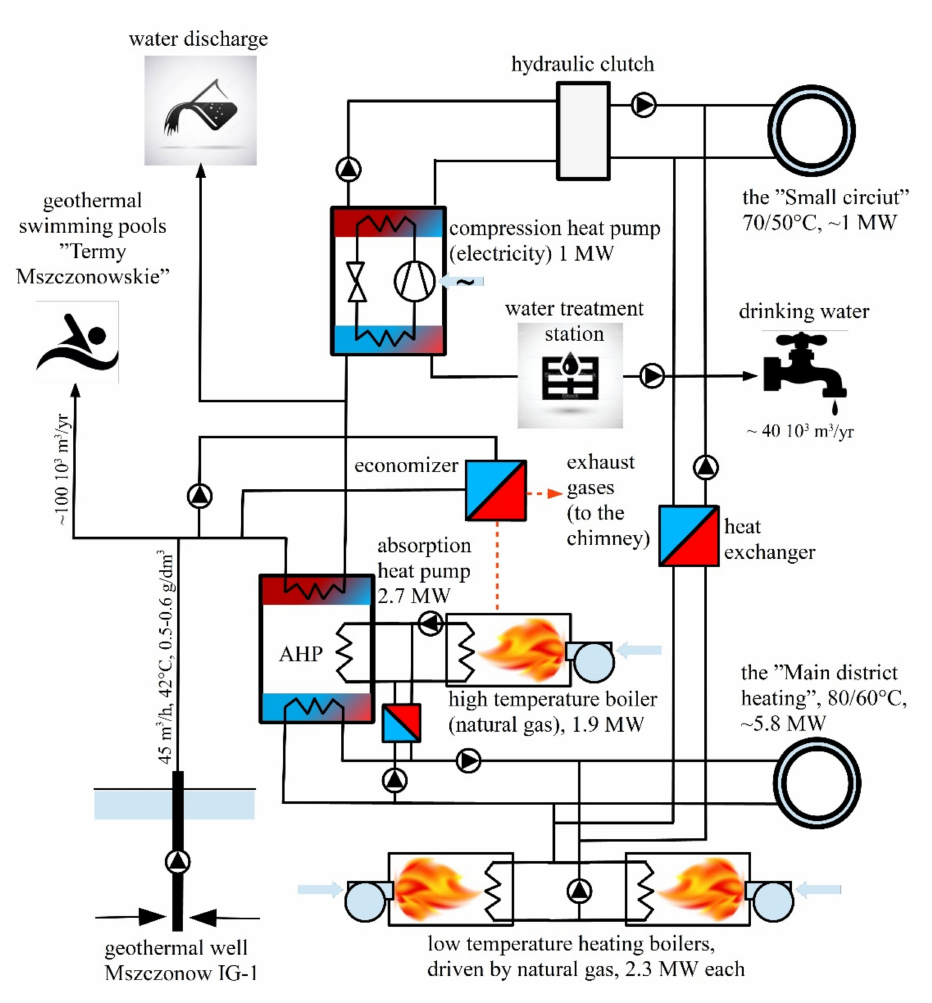
Figure 2. Diagram of the geothermal installation in Mszczon ó